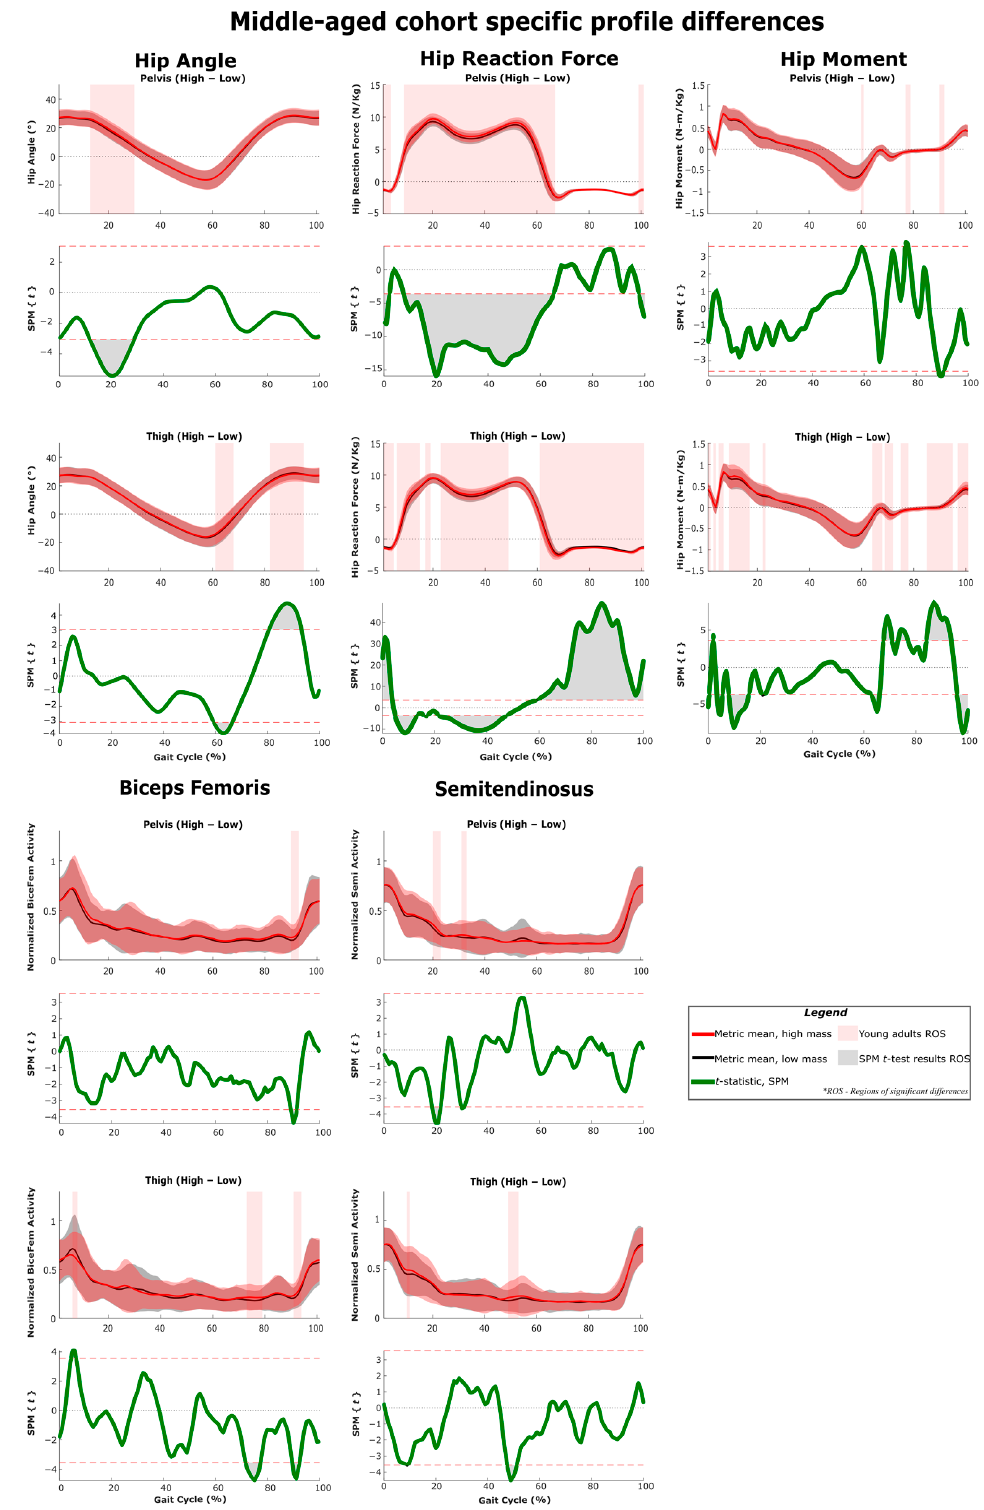
Figure 10. SPM t -test results and profile plots of the metrics, comparing low mass to high mass in the pelvis and thigh segments for participants in the middle-aged cohort. Joint parameters are primarily related to the hip joint. The t -statistic is qualitatively identical to the effect size and can be used as an indicator of practical significance.